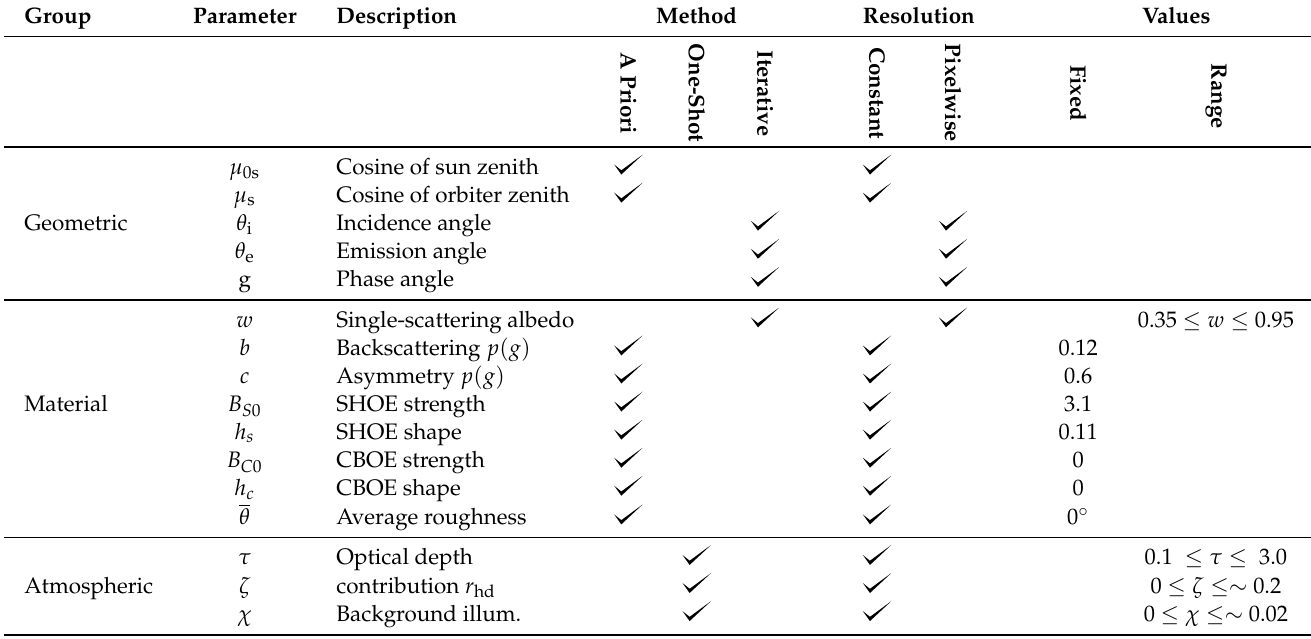
Table 1. All physical and geometric parameters of the reflectance model and atmospheric model. The shadow hiding opposition effect and the coherent backscatter opposition effect are abbreviated as SHOE and CBOE,